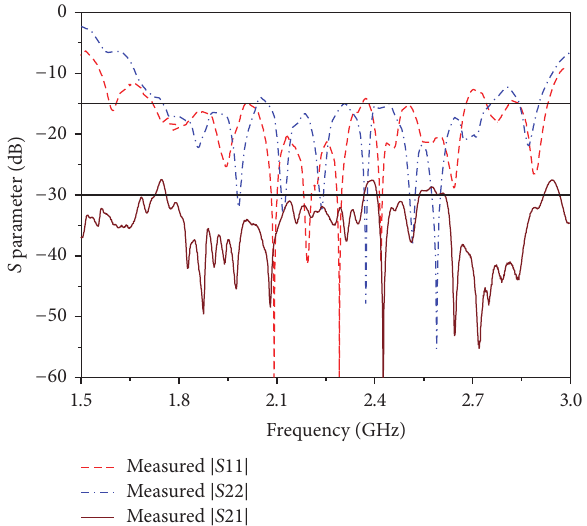
Figure 7: Measured S parameters of the V/H dual-polarized antenna